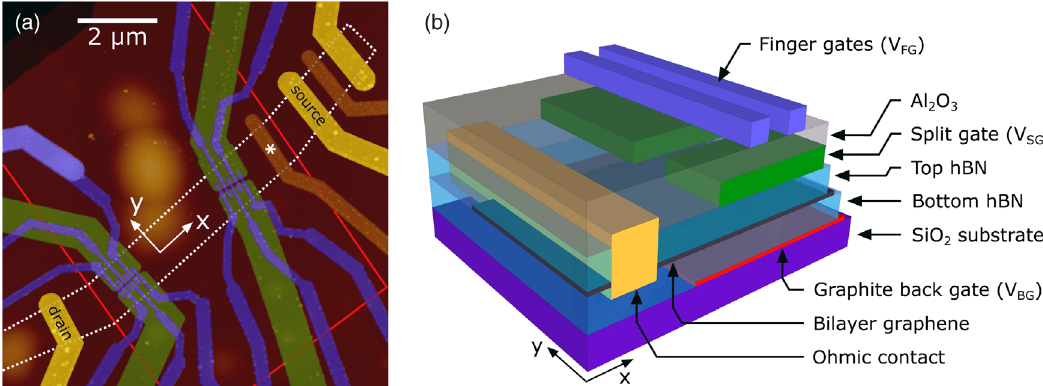
FIG. 1. (a) False color scanning force micrograph of the device. (b) 3D sketch of part of the device showing the different layers of gates and dielectrics. White dashed lines and solid red lines in (a) outline the bilayer flake and graphite back gate, respectively. Edge contacts to the bilayer are colored in yellow, split gates are shown in green, and the finger gates are shown in blue. The top gate spanning the entire width of the bilayer flake is marked with an